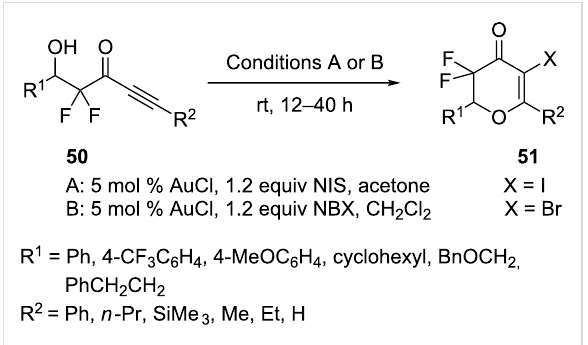
Scheme 9: Gold-catalyzed intramolecular 6-endo-dig cyclization of β -hydroxy- α , α -difluoroynones.